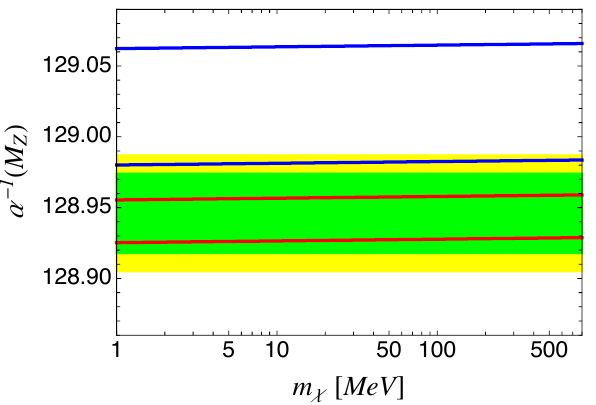
Figure 5 . The yellow (green) filled band represents 0.02% (0.01%) deviations from the central value of α − 1 ( M 2 ) obtained using ∆ α (5) ( M 2 ) | = 276 . 0(1 . 0) × 10 − 4 [9] and N χ ε 2 = 0 . The red e + e − Z Z SM had band corresponds to using ∆ α (5) ( M 2 ) | = 276 . 0(1 . 0) × 10 − 4 and N χ ε 2 = 2 . 5 × 10 − 3 . Blue band e + e − Z had corresponds to the case using ∆ α (5) ( M 2 ) | EW-fit = 270 . 2(3 . 0) × 10 − 4 [19] and N χ ε 2 = 2 . 5 × 10 − 3 . Z had For mCPs with m = 15 MeV and N ε 2 = 2 . 5 × 10 − 3 as a benchmark scenario, χ χ ∆ α ( M 2 ) = 122 . 0 × 10 − 4 · N ε 2 = 3 . 05 × 10 − 5 which is smaller than the error size χ χ Z